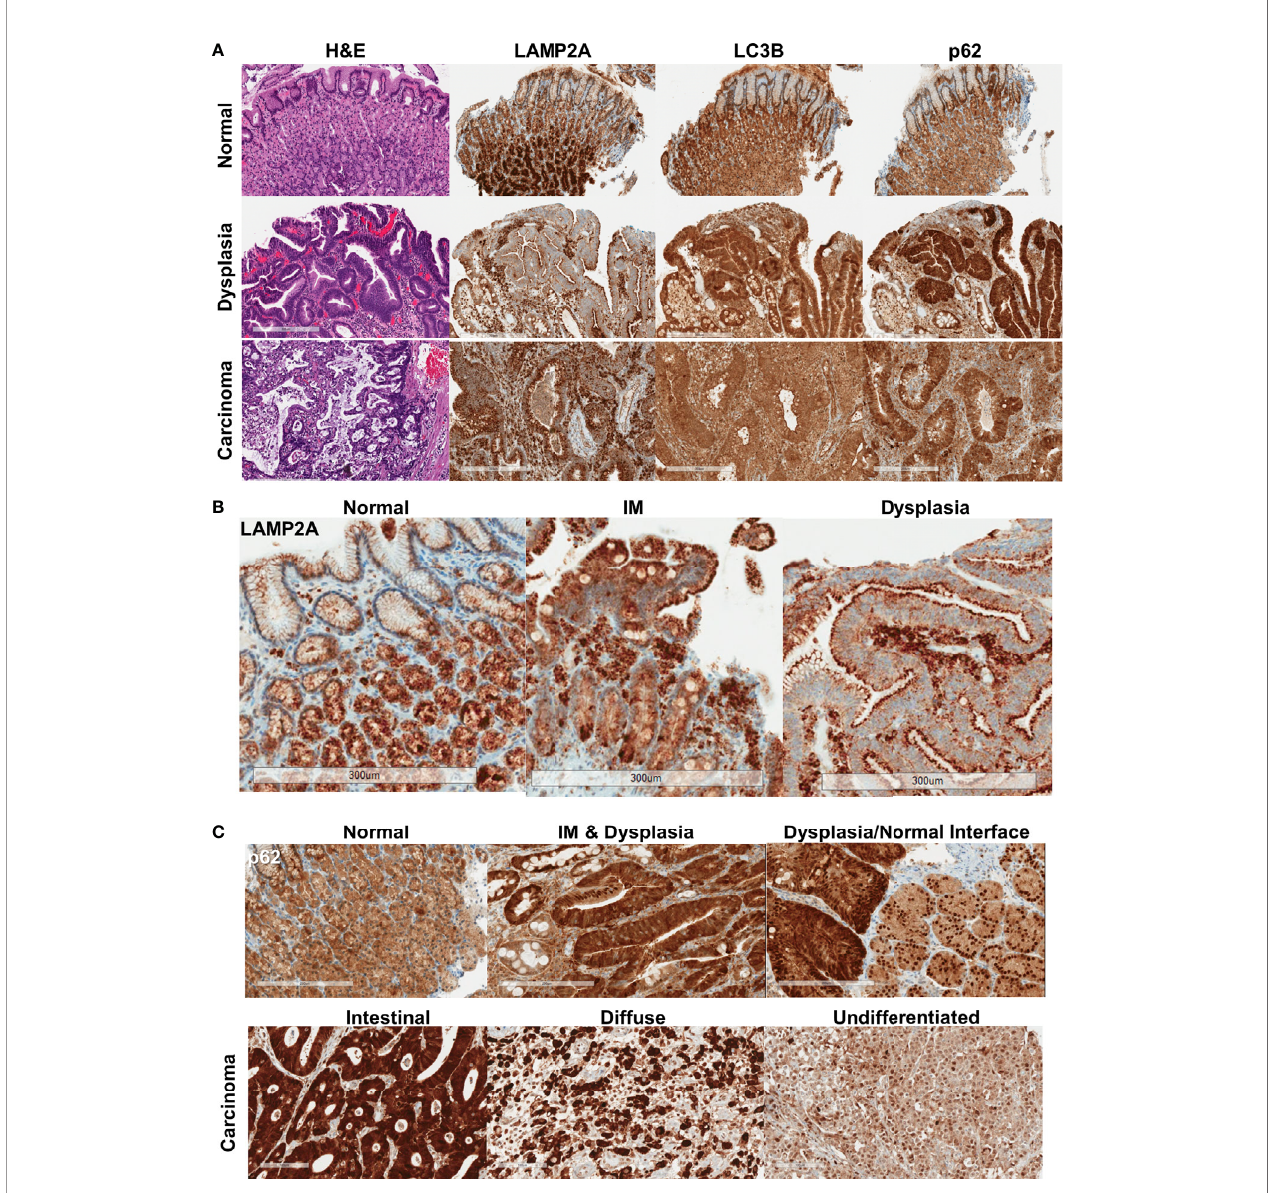
FIGURE 1 | (A) Protein expression pattern of three autophagy markers in non-dysplastic, dysplastic, and carcinomatous gastric epithelium. (B) LAMP2A expression patterns seen in normal, intestinal metaplasia (IM) and dysplastic surface mucosa. (C) p62 expression patterns, with the bottom panel showing the different expression patterns in different histotypes of carcinoma. Bar = 300 m